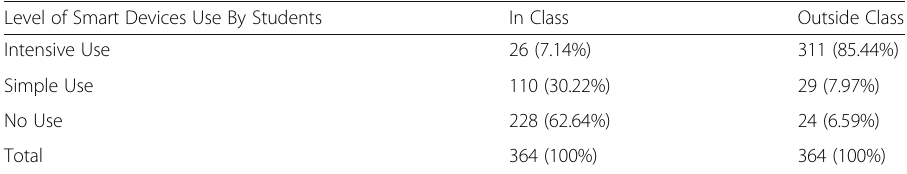
Table 4 Level of smart devices use by students Level of Smart Devices Use By Students